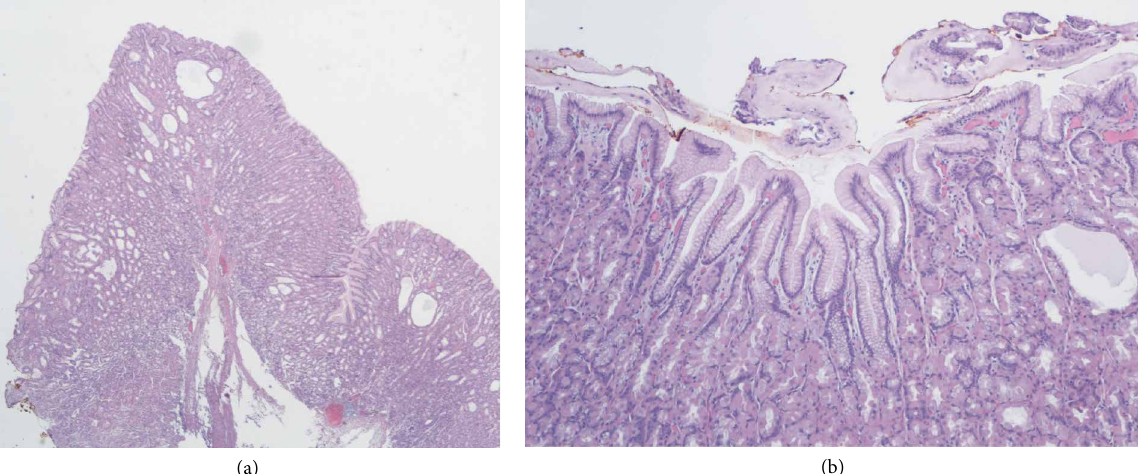
Figure 2: (a) Gastric folds biopsy on low power magnification showing mucosal thickening with foveolar hyperplasia and cystic dilatation of the gland (H and E, magnification ×2) consistent with Menetrier disease. (b) Another section of the gastric folds biopsy showing foveolar hyperplasia with excessive mucous spills on the luminal surface and a cystically dilated gland (H and E, magnification ×100).